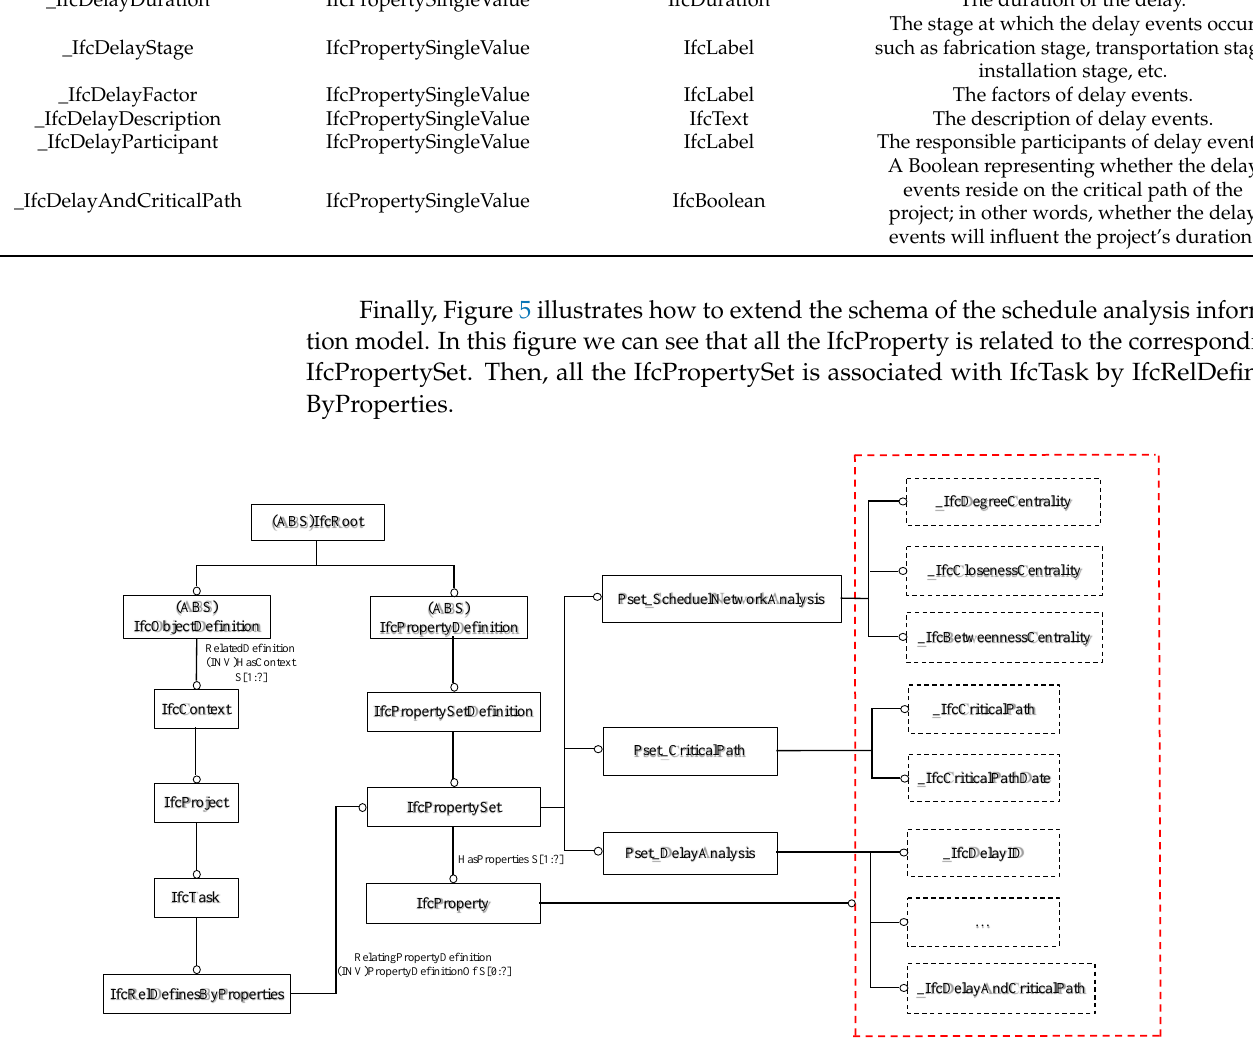
Figure 5. Schedule analysis information’s extension model.